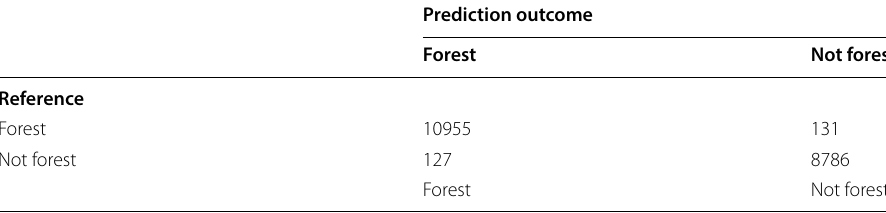
Table 3 Confusion matrix results for input random forest for image 09/08/2017